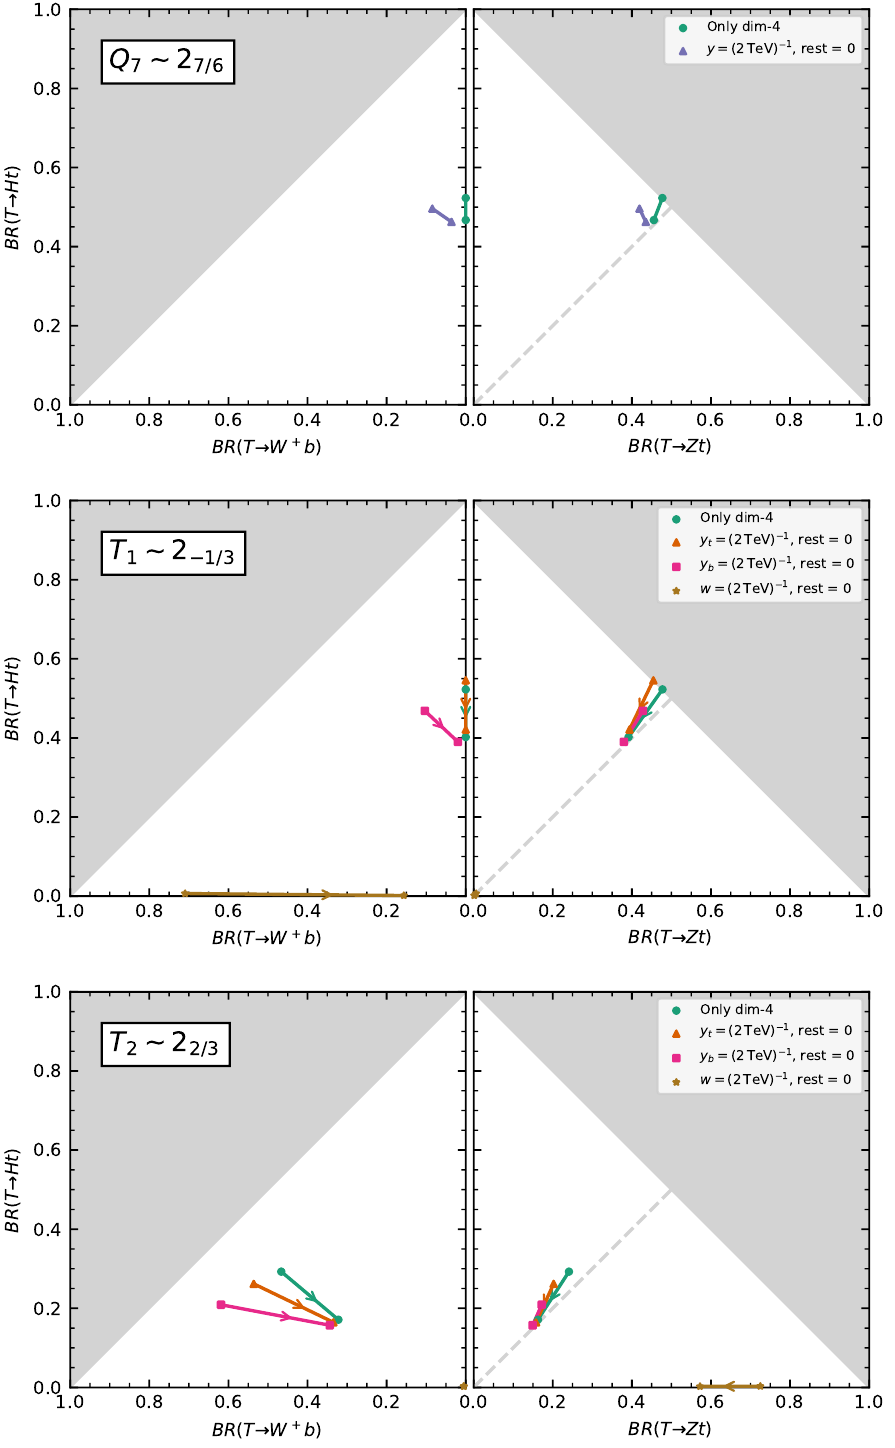
Figure 11 . Branching ratios of T into Ht , Zt and W + b for various values of the parameters in the Q 1 , T 2 and T 1 models. The dimensionless couplings (cid:21) are always chosen to saturate the corresponding electroweak precision bounds.